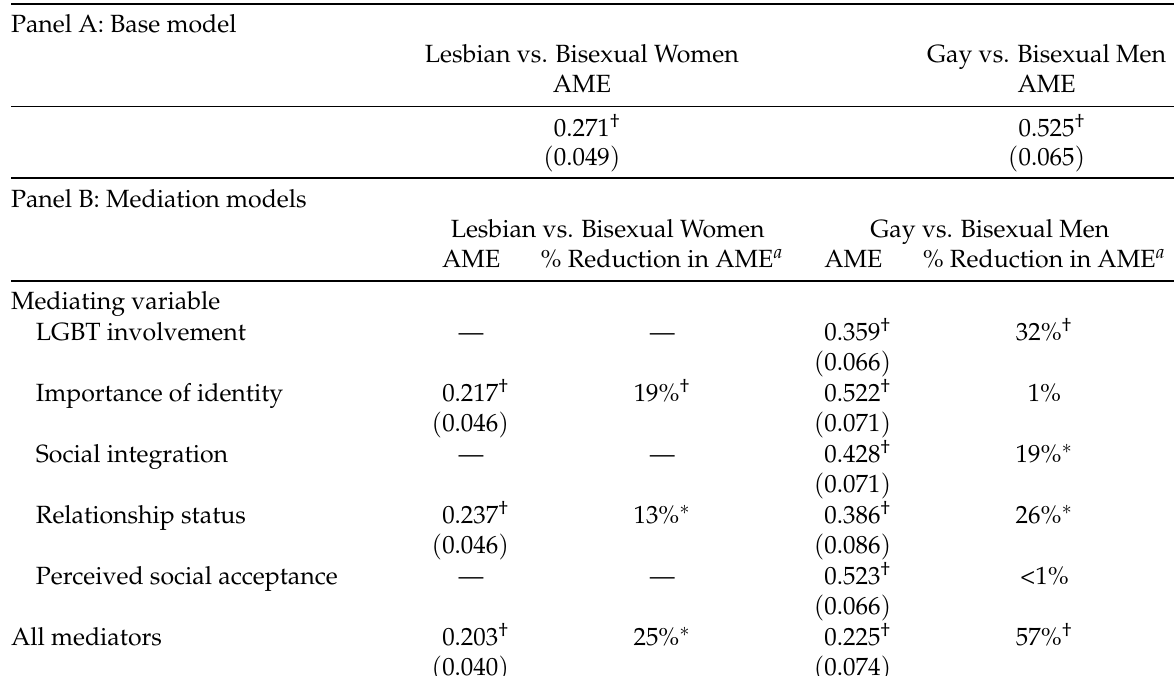
Table 6: Average marginal effects of sexual orientation identity before (Panel A) and after (Panel B) accounting for various mediating